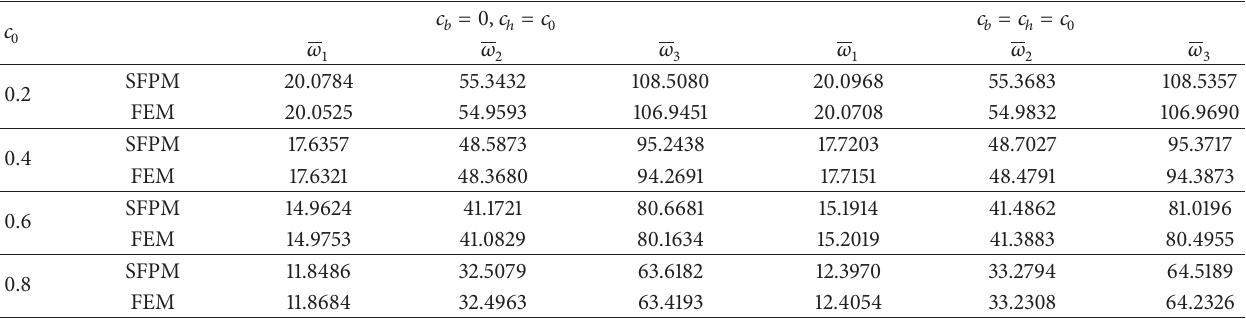
Table 4: Nondimensional transverse natural frequencies 𝜔 𝑖 for tapered homogenous beam; boundary condition: C-C. 𝑐 0